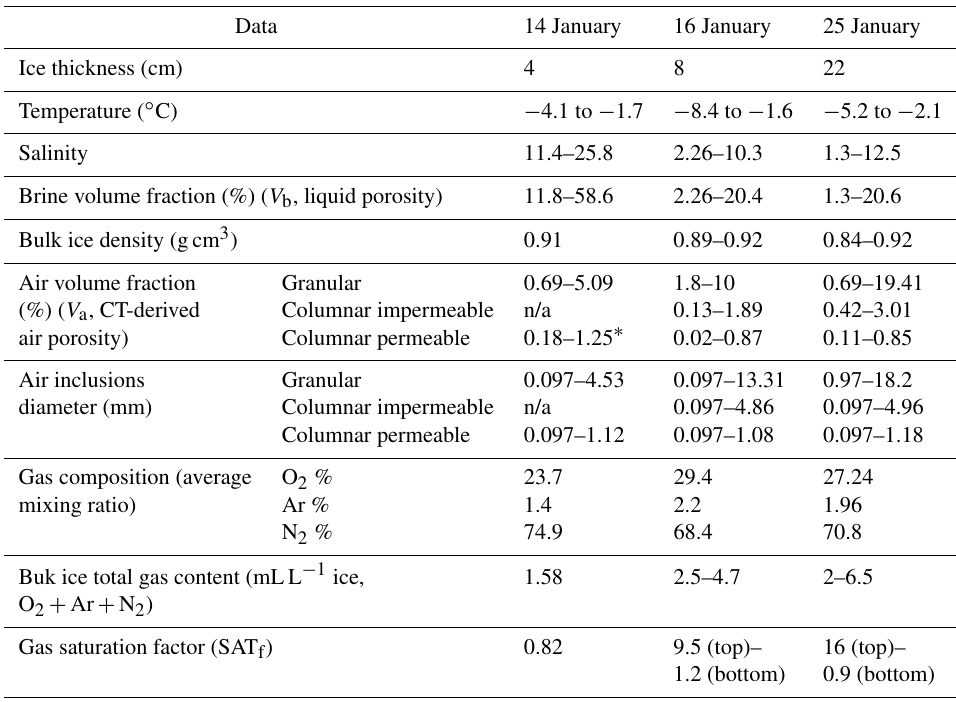
Table 3. Summarizes the main sea ice characteristics and sea ice properties.